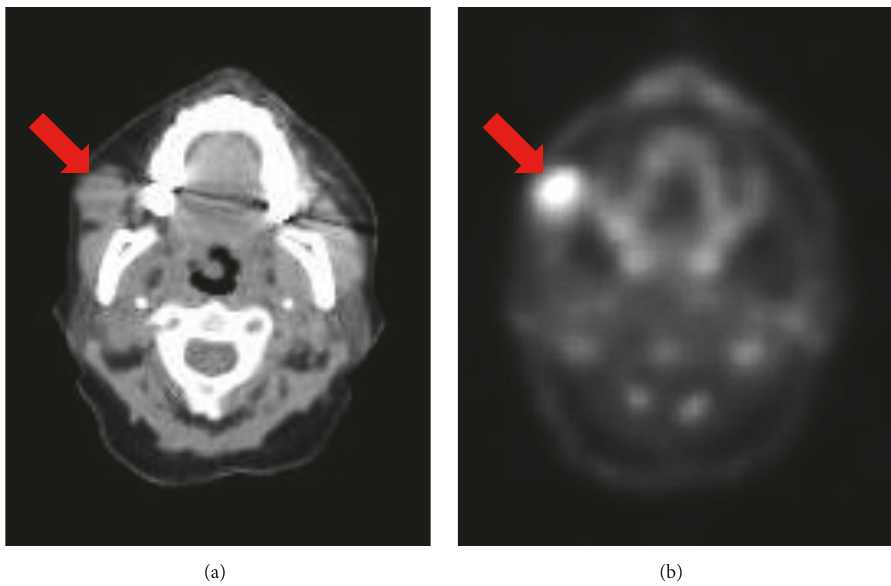
Figure 1: CT (a) and PET (b) images of the FDG-avid mass, centered along the anterior aspect of the right masseter muscle, not involving